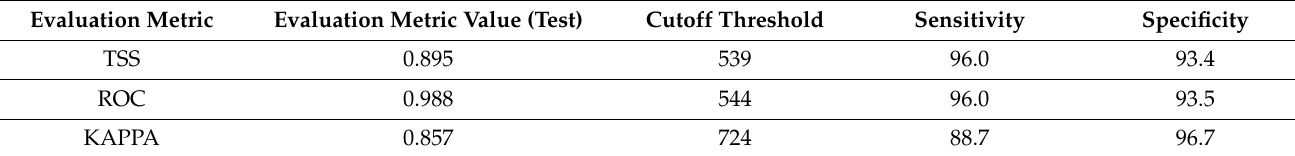
Table 4. Performance evaluation scores for the final ensemble classifier combining biomod2 algorithms. Evaluation Metric